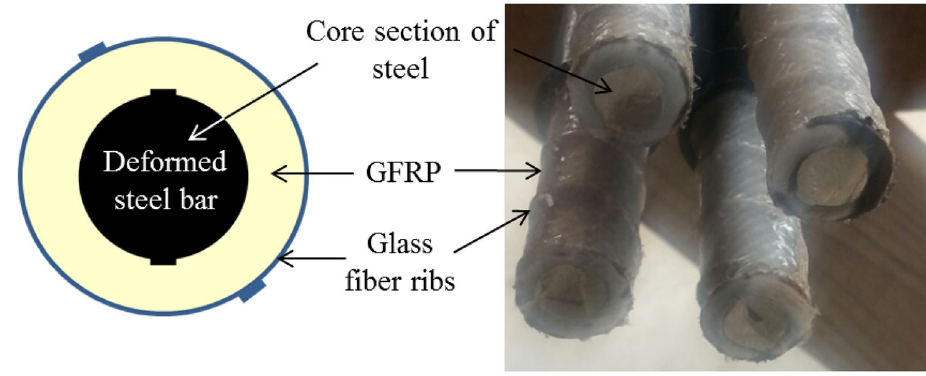
Fig. 1 Geometry and product of GFRP and deformed steel hybrid